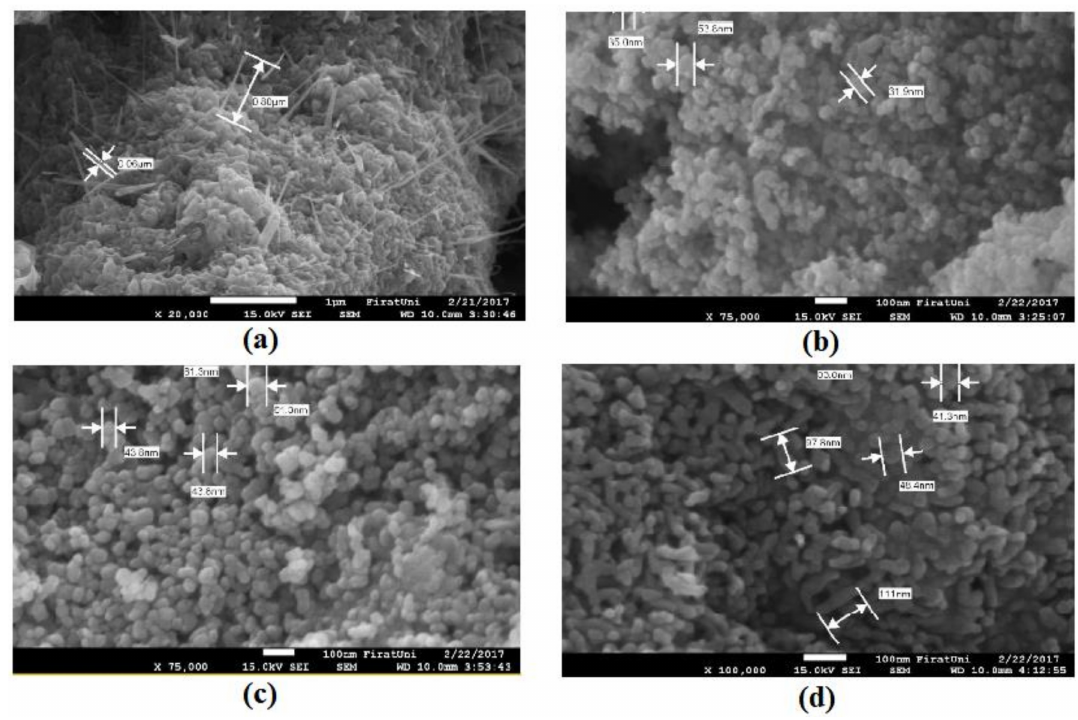
Figure 1. The scanning electron microscope (SEM) image of CuO, ( a ) CuO pH 7 nanoparticle; ( b ) CuO pH 10 nanoparticle; ( c ) CuO pH 12 nanoparticle; ( d ) CuO pH 14